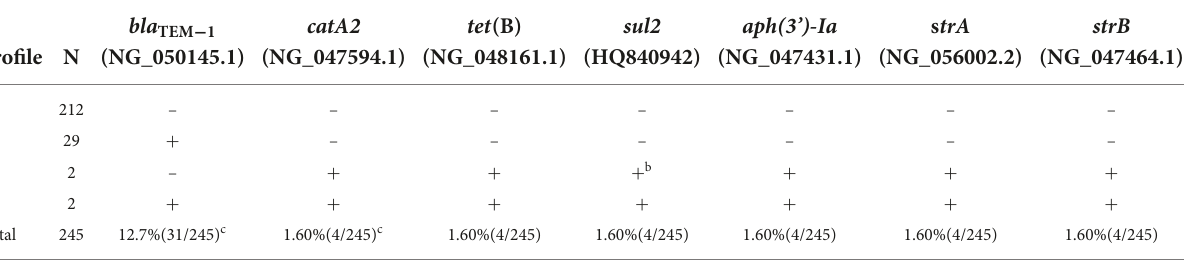
TABLE 2 Antibiotic resistance gene profiles in 245 invasive Haemophilus influenzae isolates in Norway, 2017–2021, detected by ResFinder and AMRFinderPlus in